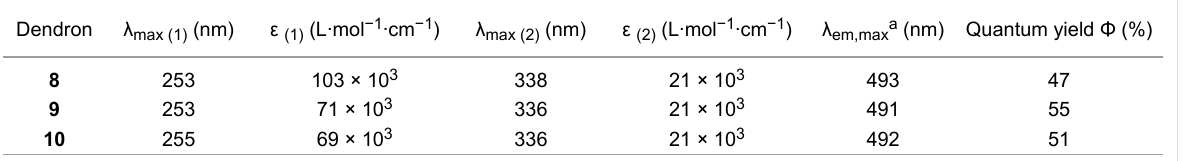
Table 1: UV–vis characteristics and fluorescence characteristics of dendrons 8 – 10 in 1,4-dioxane.